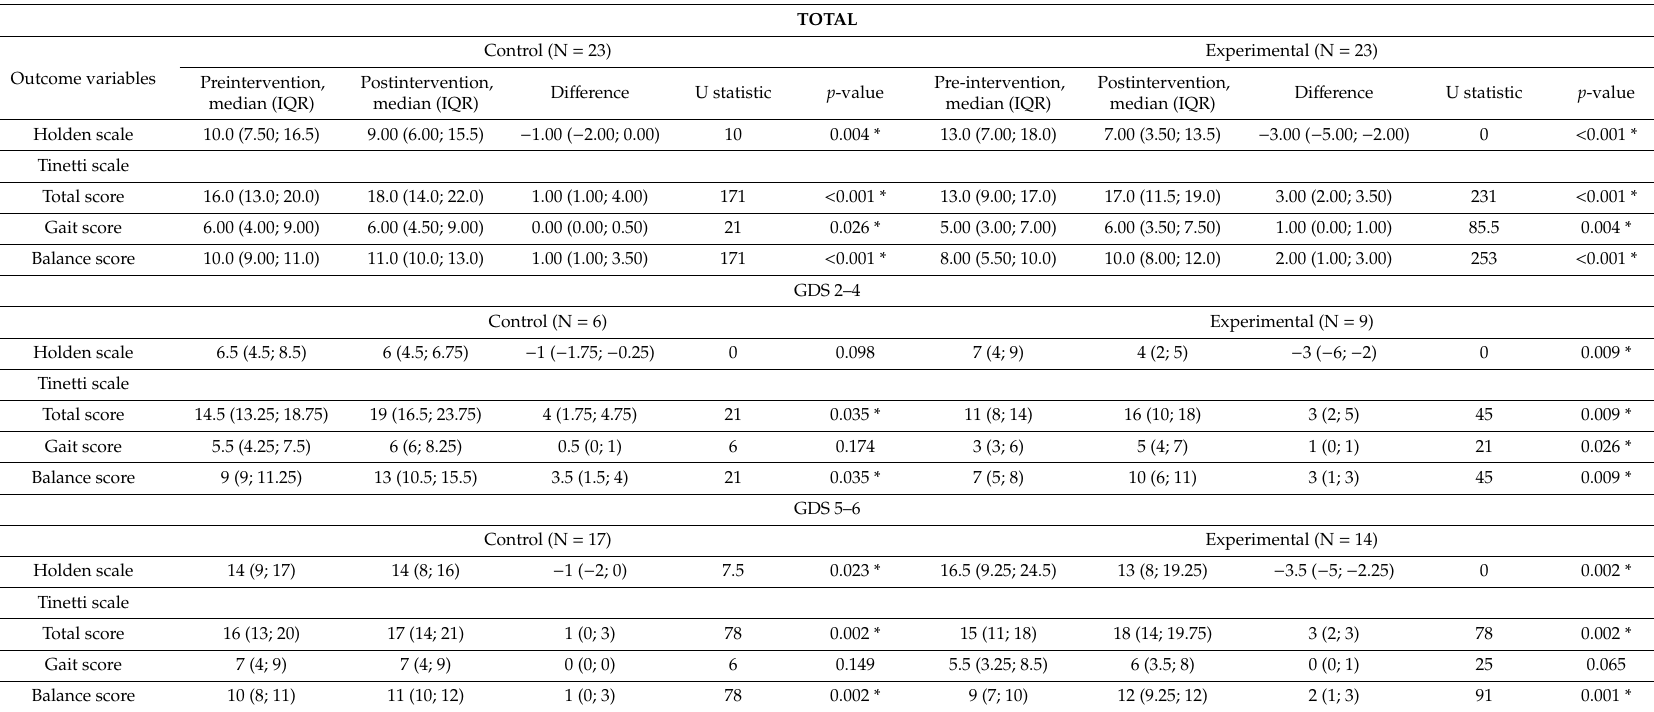
Table 2. Comparison between the Holden and Tinetti scale scores of the study participants pre- and